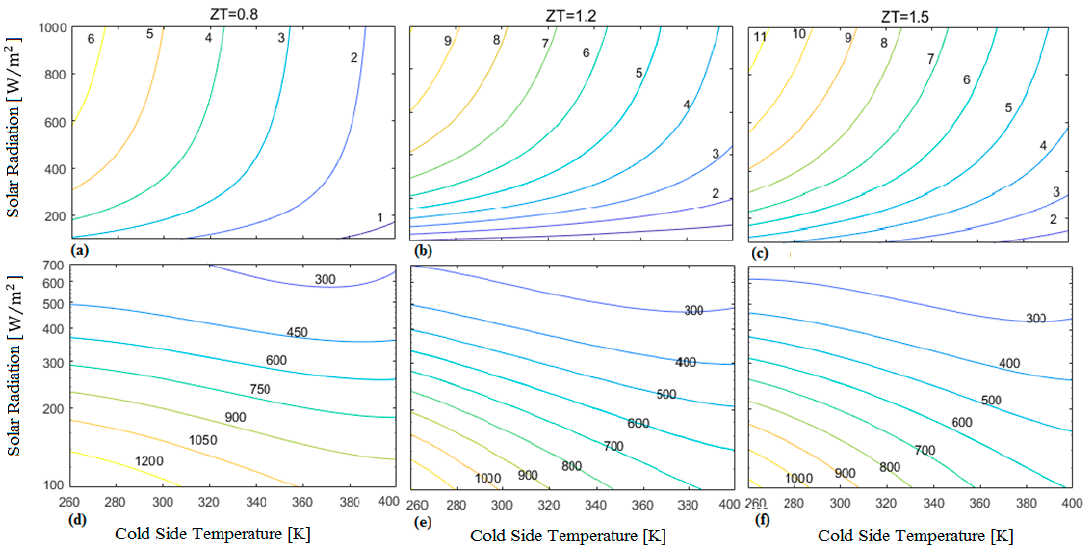
Figure 8. ( a – c ) Efficiency contours for different TEG properties according to cold side temperature and solar radiation intensity. ( d – f ) Optimum thermal concentration for different TEG properties according to cold side temperature and solar radiation intensity. In the case where ZT, cold side temperature, and radiation are 0.8, 300 K, and 300 W/m 2 , respectively, the optimum TC is 750 and the maximum efficiency is 3.8%.